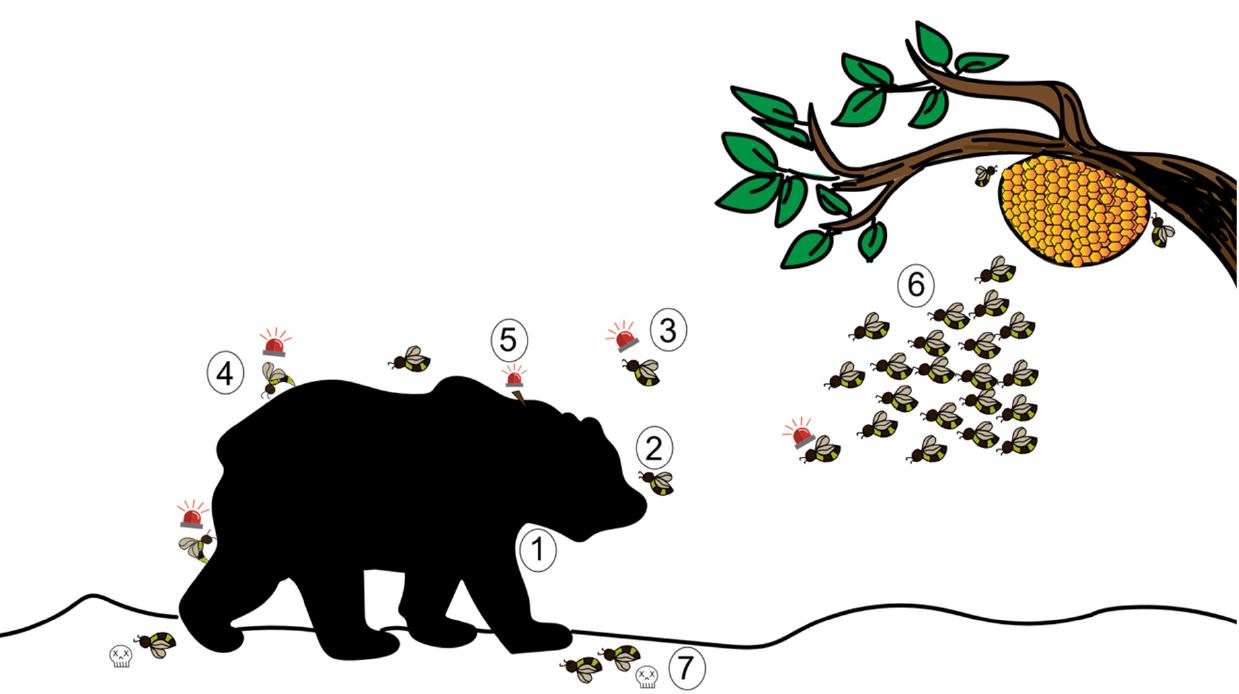
Figure 2. The defensive behaviour of a honeybee using sting alarm pheromone (SAP) against a mammalian predator. ① : A large mammal acts as a trigger to honeybees; ② : A guard bee flies in to check the threat; ③ : Guard bees release alarm pheromones depending on the nature of the threat; ④ : Recruited conspecifics react to the SAP by stinging the threat; ⑤ : This results in the detachment of the stinger from the bee’s abdomen, which in turn also sends out SAP; ⑥ : Groups of bees that are triggered upon release of the SAP attack the threat; ⑦ : Stinging results in the death of the bees (an altruistic self-destructive act).